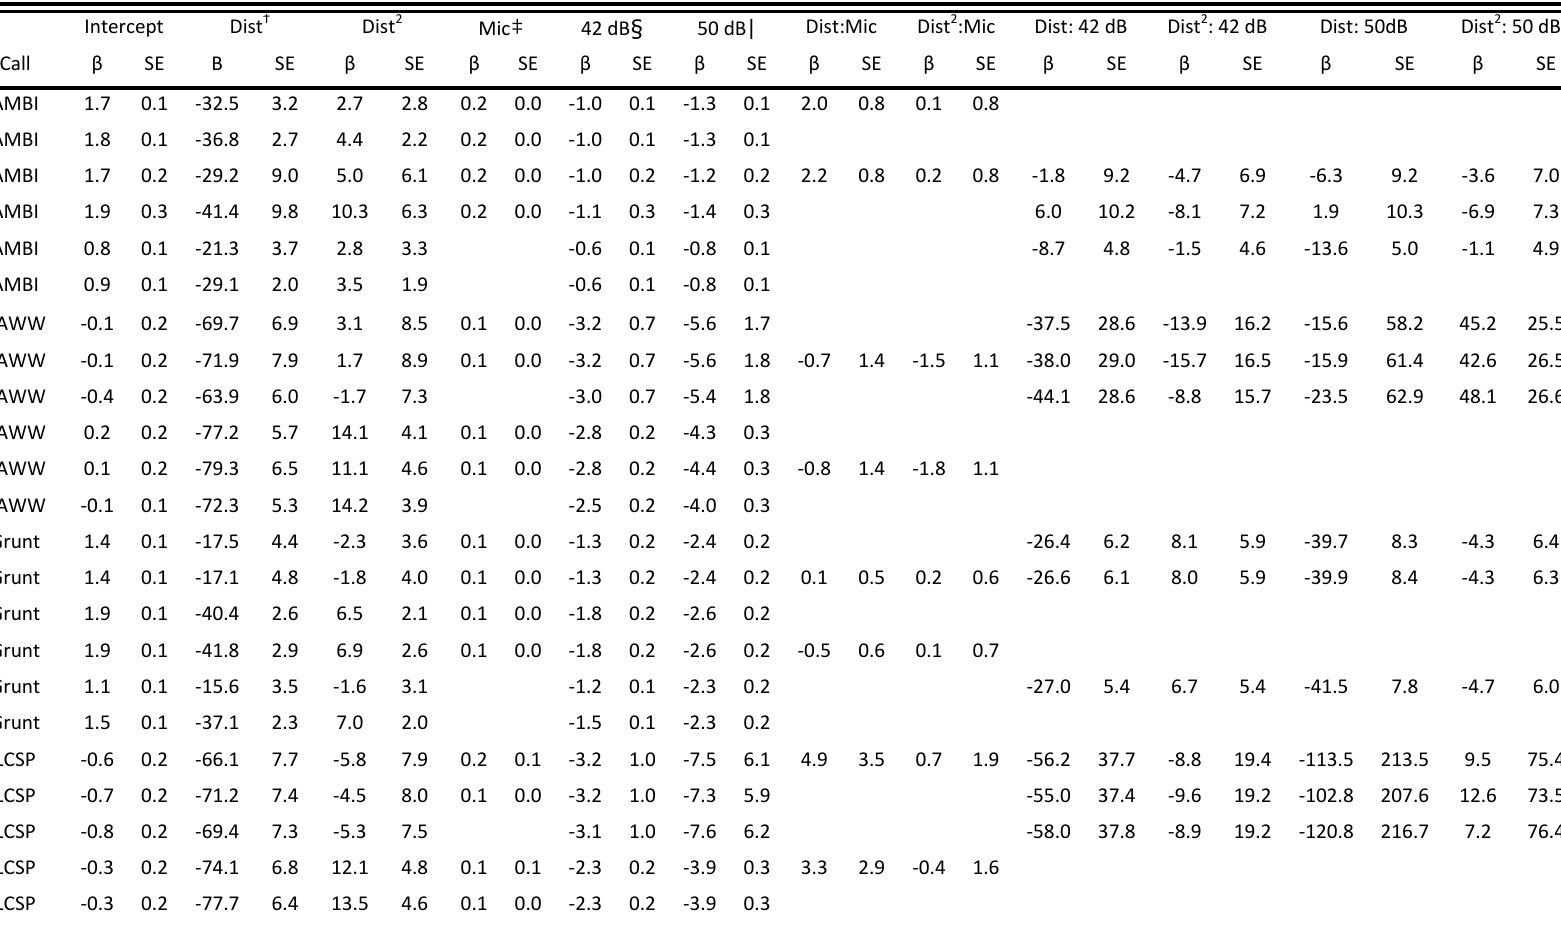
Appendix 3. Parameter estimates for all binomial regression models. Within a species, models are ranked from lowest to highest ΔAIC c